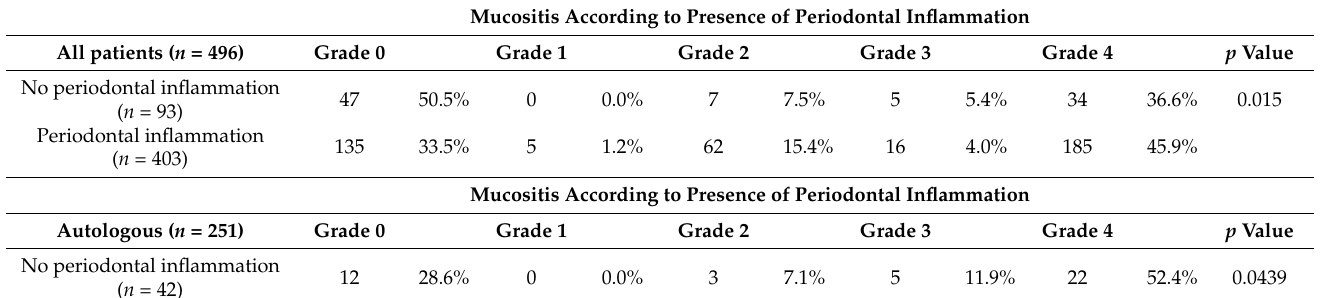
Table 6. Oral mucositis in SCT subgroups according to the presence of periodontal